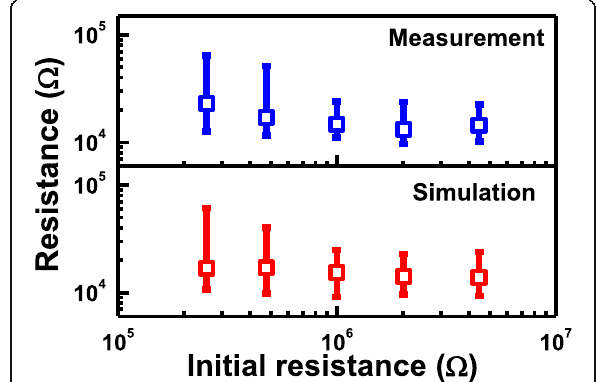
Fig. 13 Analysis of resistance level variation after forming operation is examined through both simulation and measurement. Higher variation induced by dendritic CF generation is found in cells with low initial resistance